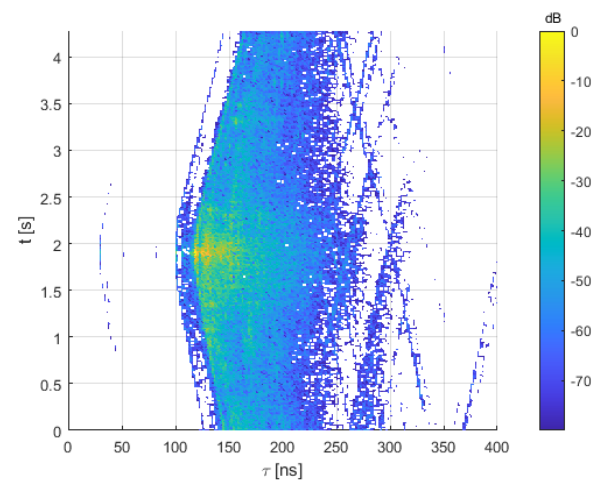
Figure 13. Measured PDPs for the alley at low speeds (less than 25 km/h).